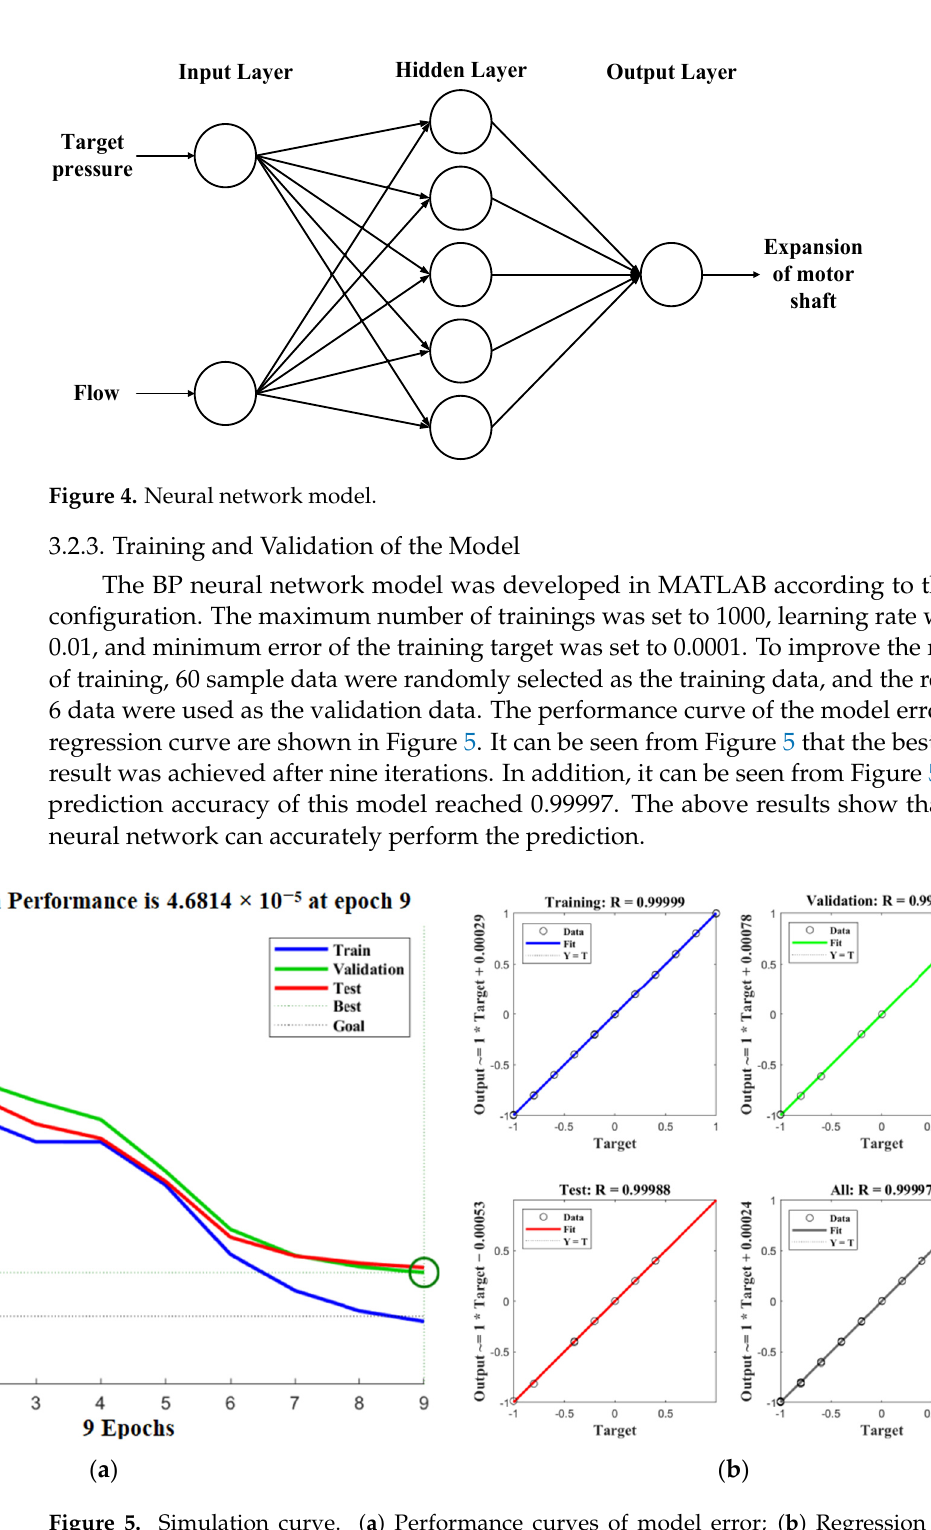
Figure 5. Simulation curve. ( a ) Performance curves of model error; ( b ) Regression curves of model error.